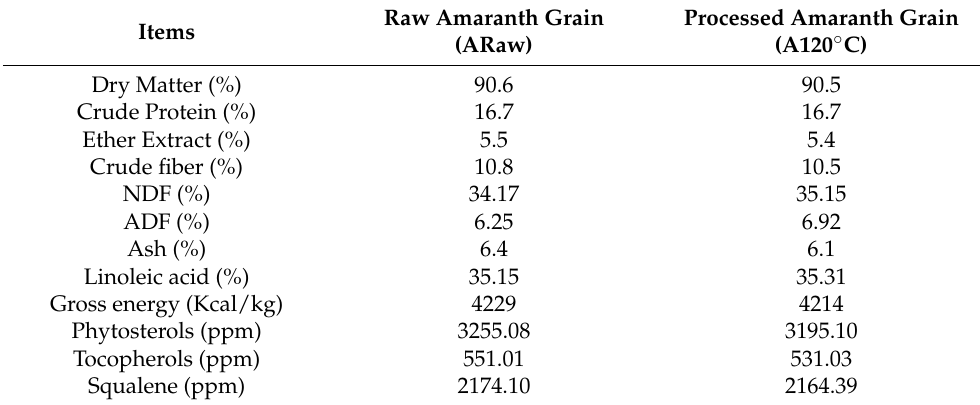
Table 2. Values of chemical compositions and phytosterols, tocopherols and squalene content in raw and processed (120 ◦ C for 5 min) Amaranthus hybridus chlorostachys